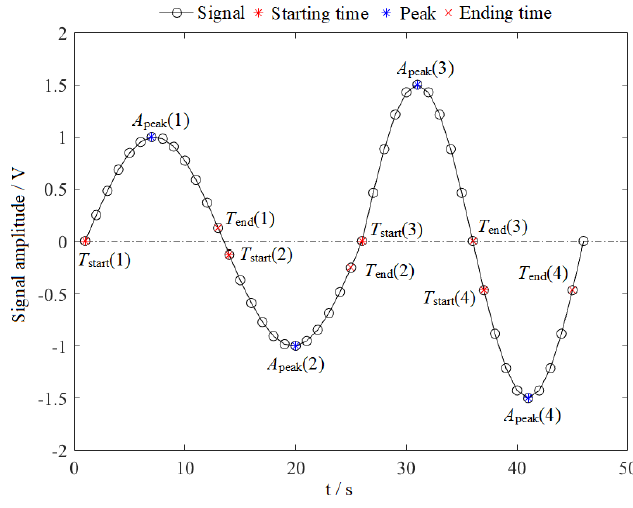
Figure 4. Signal decomposition diagram.